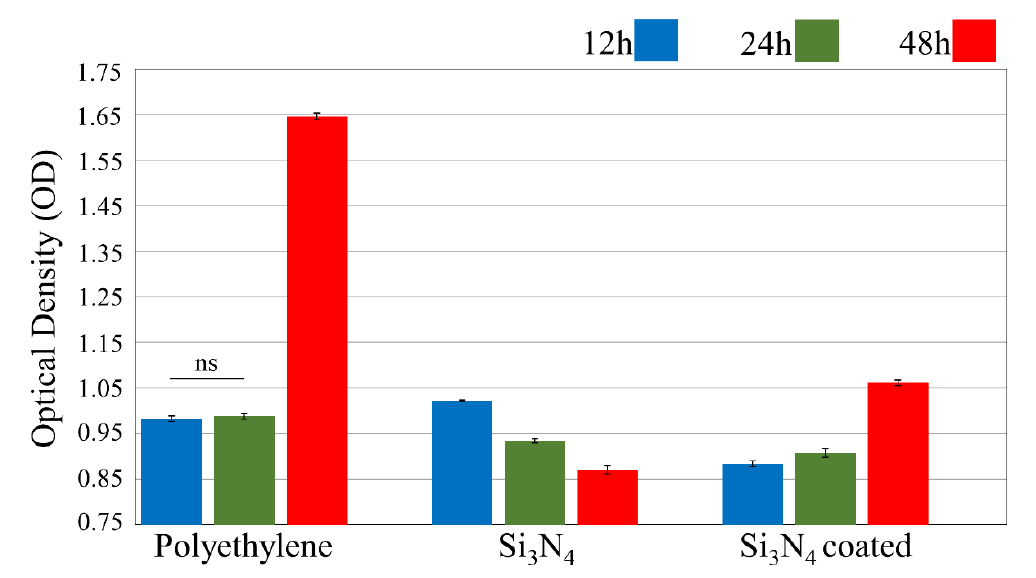
Figure 5. Biological assay of Staphylococcus epidermidis as a function of bacterial exposure time.